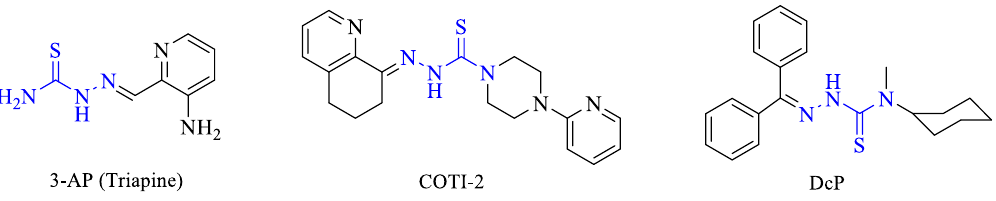
Figure 2. Representative compounds containing thiosemicarbazone groups.